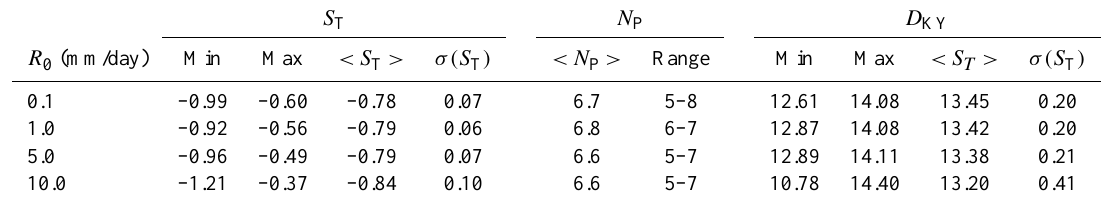
Table 2. Minimum, maximum and expected values and standard deviations of the sum of all Lyapunov exponents, S T , and the Kaplan-Yorke, D KY , dimension. Range and expected values of the number, N P , of positive Lyapunov exponents are also included. S T N P